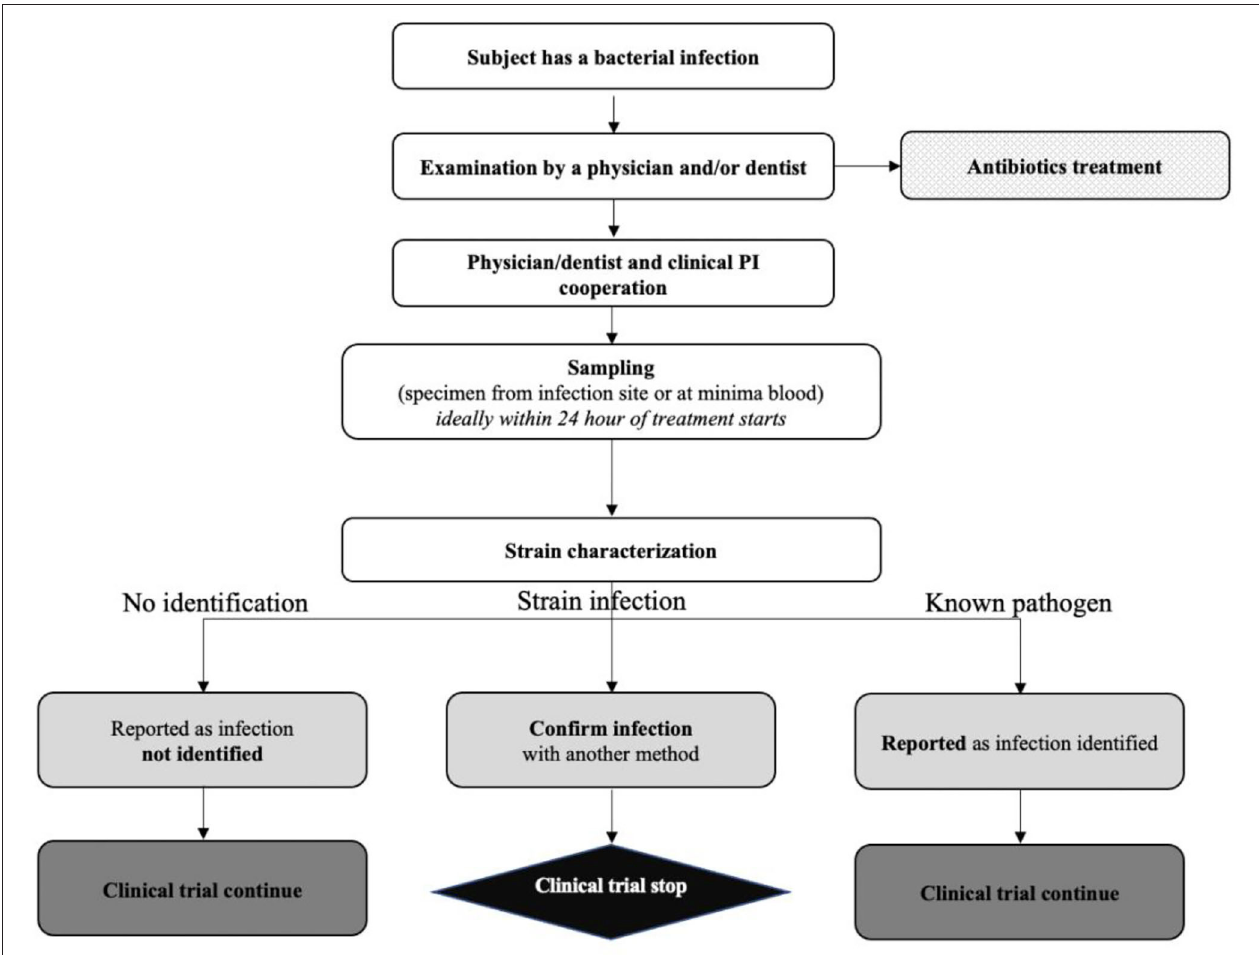
FIGURE 1 | YSOPIA risk management plan to manage potential clinical infection applied during phase 1 trial.